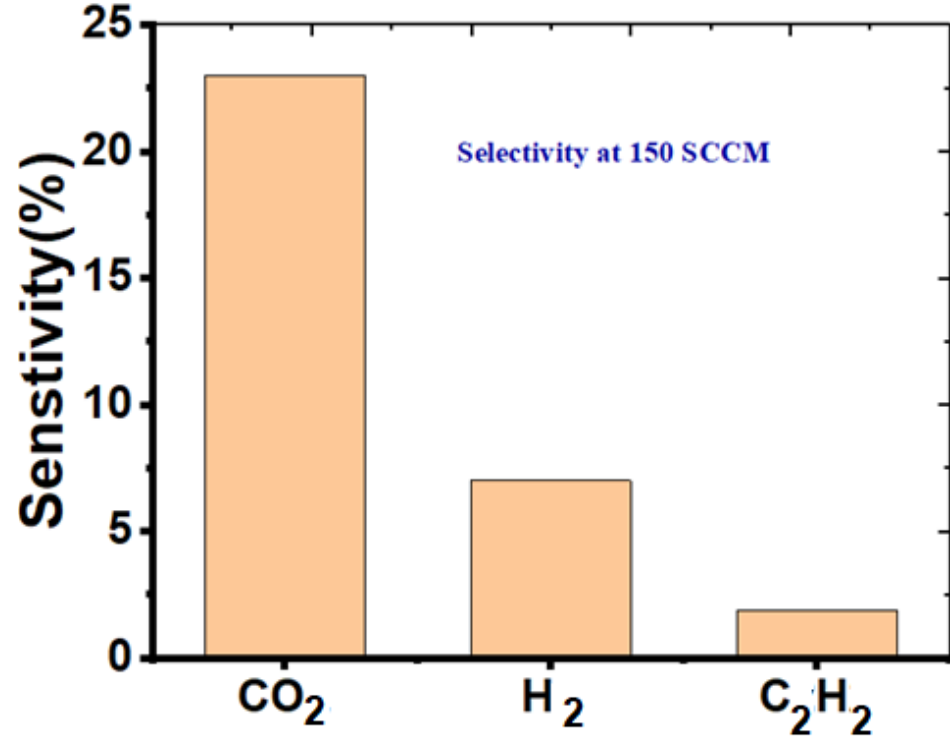
Figure 10. The selectivity of ZnO/CNTs for CO 2 gas.